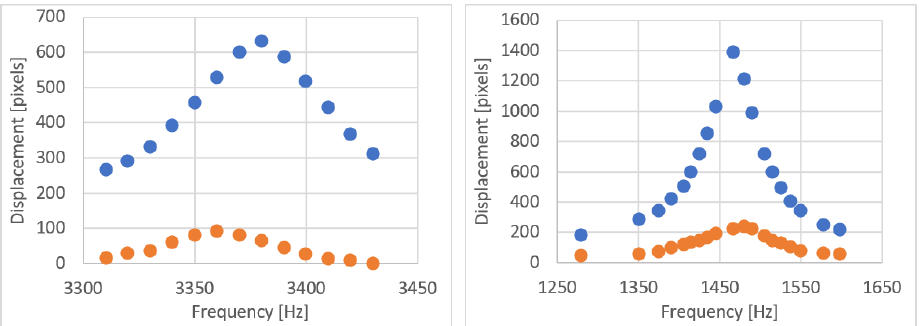
Figure 20. Tip displacement of the cantilever fiber (along major axis of the ellipse in blue and along minor axis of the ellipse in orange) with frequency change for two samples actuated by a bridge having shape like that of design D.